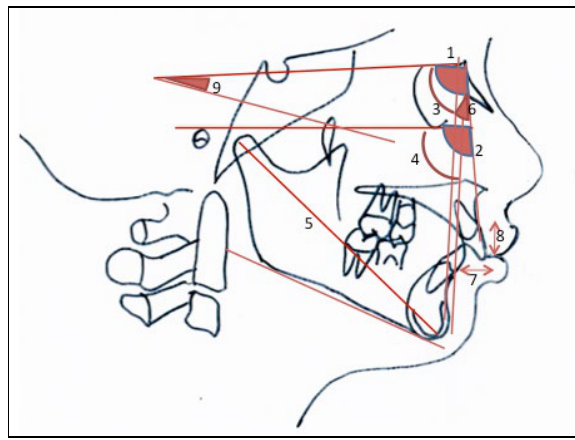
Figure 1. 1.SNA(°): angle between NA and SN plane; 2.Maxillary depth(°): angle between NA and FH plane; 3.SNB(°): angle between the NB line and SN plane; 4.Facial depth(°): angle between N-Pg line and FH plane; 5.Co-Gn (mm): mandibular length between points Co and Gn; 6.ANB(°): angle between NA and NB lines; 7.Overjet (mm): distance between the incisal edges of the maxillary and mandibular central incisors, parallel to the occlusal plane; 8.Overbite (mm): distance between the incisal edges of the maxillary and mandibular central incisors, perpendicular to the occlusal plane; 9.GoGnSN(°): angle between the SN plane and the mandibular plane angle.